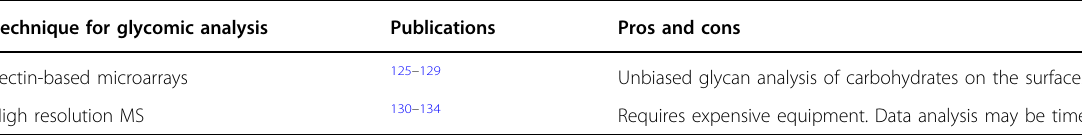
Table 3 Glycomic technologies used for EV analysis Technique for glycomic